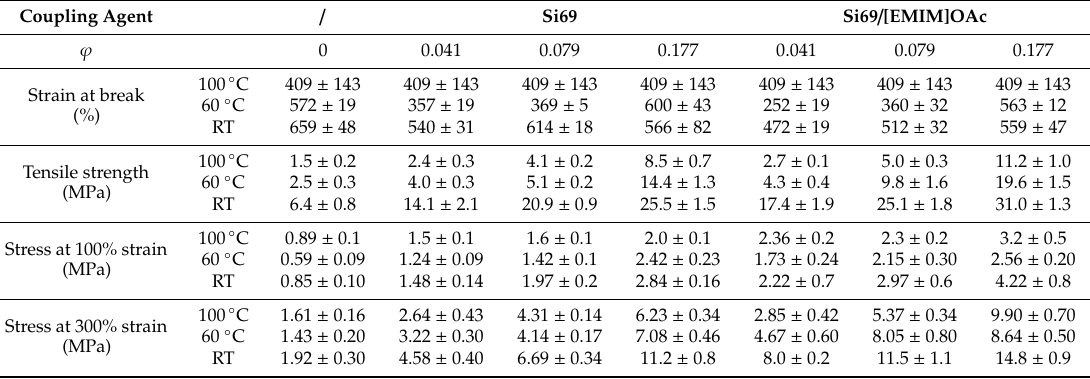
Table 2. Mechanical properties of NBR vulcanizate and its Si69–or Si69 / [EMIM]OAc-containing nanocomposites. Coupling Agent